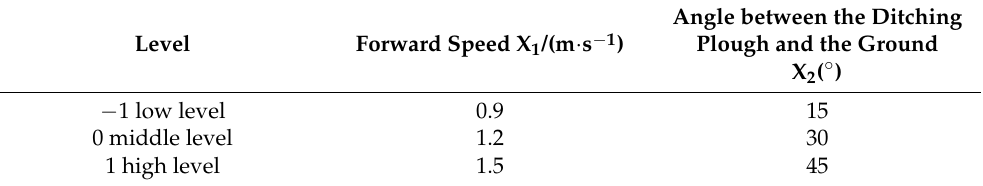
Table 3. Response surface test factor and levels.